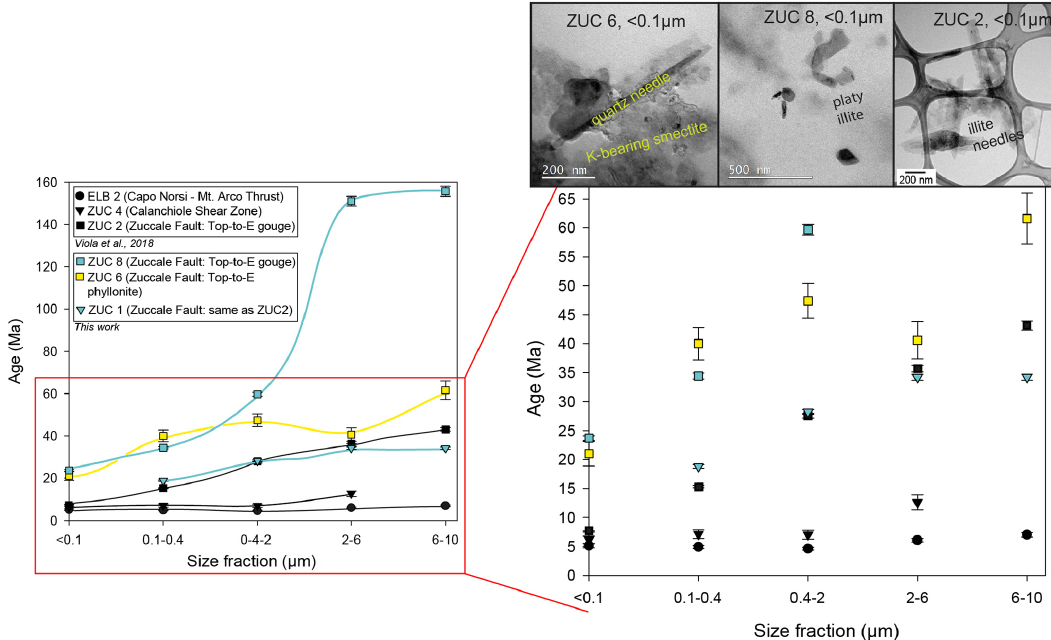
Figure 8. K–Ar age vs. grain size spectra for the three dated samples (in colour) compared and contrasted with the results by Viola et al. (2018) in black. (b) Selected transmission electron microscope images of the finest dated fractions of ZUC 6 and ZUC 8 from this study. The image of ZUC 2 is from Viola et el. (2018). Colours correspond to those used for the dated BSFs in Fig.